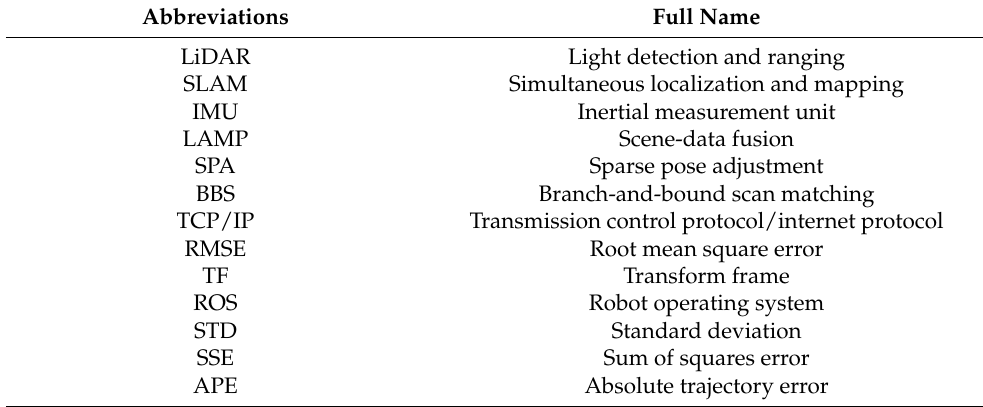
Table 1. The abbreviations used in this